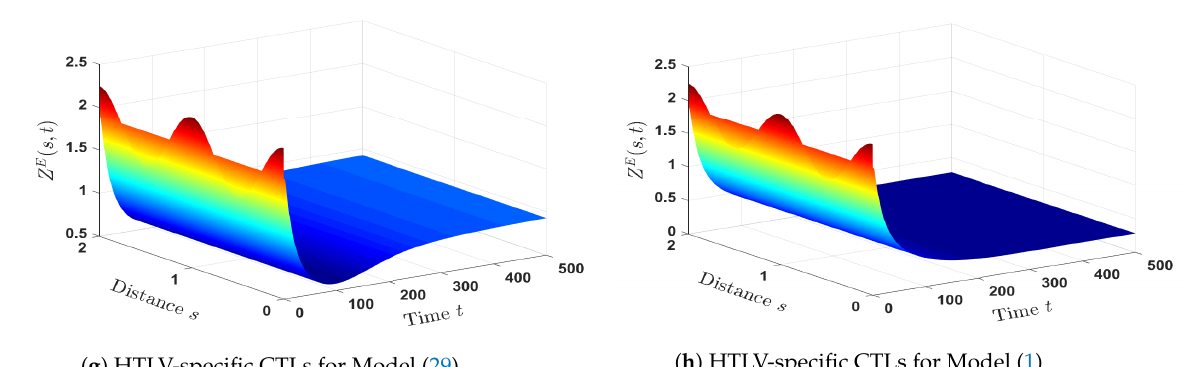
Figure 10. Comparison between the solutions of two models: HTLV mono-infection Model (29) and HTLV/HIV co-infection Model (1), under the initial conditions (26) and boundary conditions (27), taking ω 1 = 0.0005, ω 2 = 0.0002, ω 3 = 0.0003, ω 4 = 0.01, υ 1 = 0.05, υ 2 =